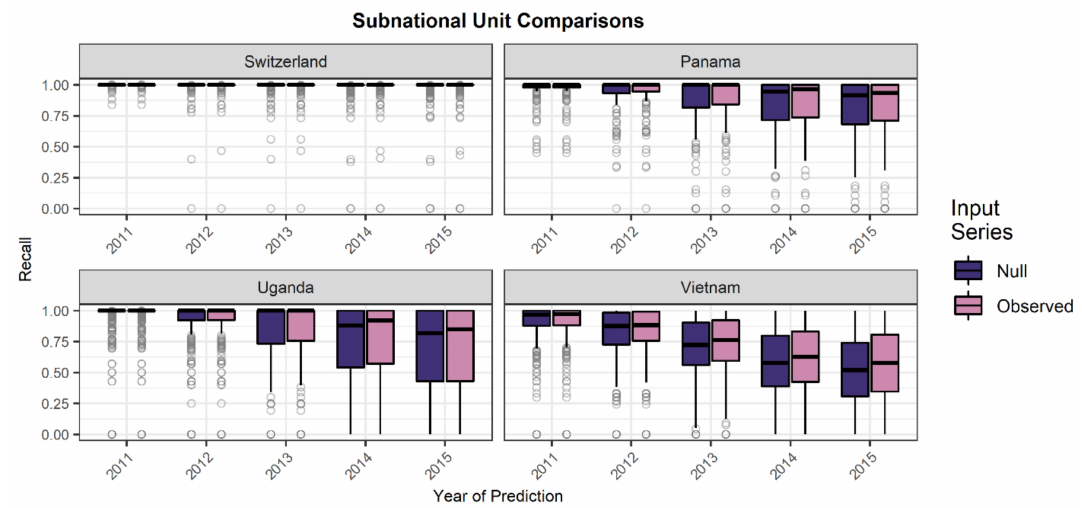
Figure 4. Boxplots of unit-level recall scores across countries and years in the projection period and divided by the input time series to the BSGMe framework. All recall values were calculated by comparing pixel-level agreement / disagreement with withheld annual ESA RS-derived extents. The median is indicated by the black line and outliers (outside of 1.5*the interquartile range) are given by grey